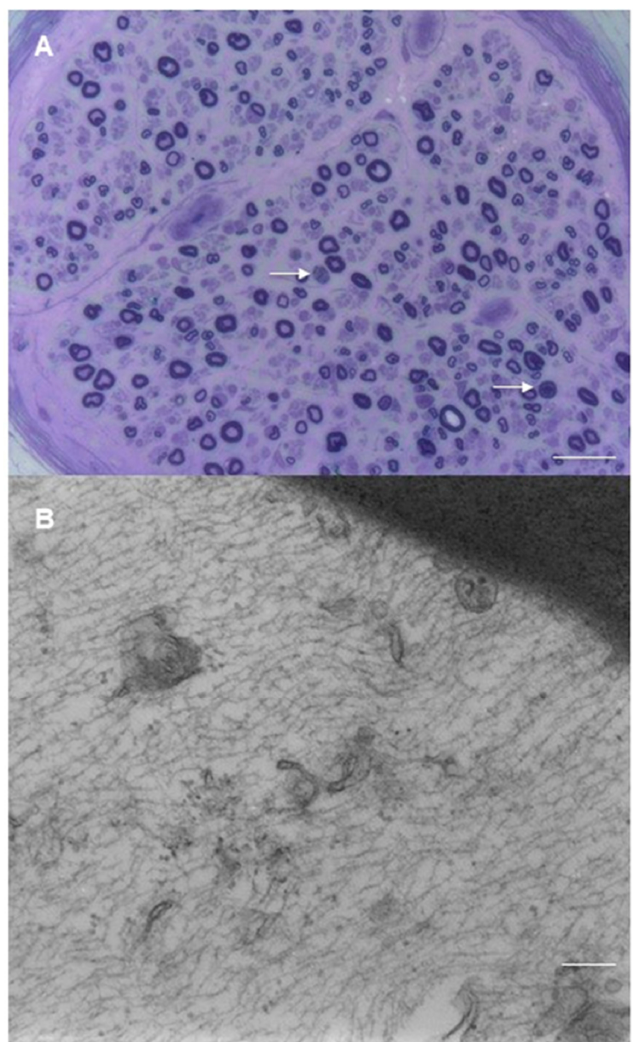
Figure 6. Sural nerve biopsy from a patient with brentuximab vedotin-related neuropathy. ( A ) axonal neuropathy is characterized by very mild loss of myelinated fibers; rare wallerian degenerations are present (arrow) (semithin section, toluidine blue, original magnification 40×; bar 50 mm). ( B ) A myelinated fiber shows an altered composition of cytoskeleton constitutes: is evident a relative preservation of neurofilaments and a significative depletion of microtubules (original magnification 30,000 × ; bar 300